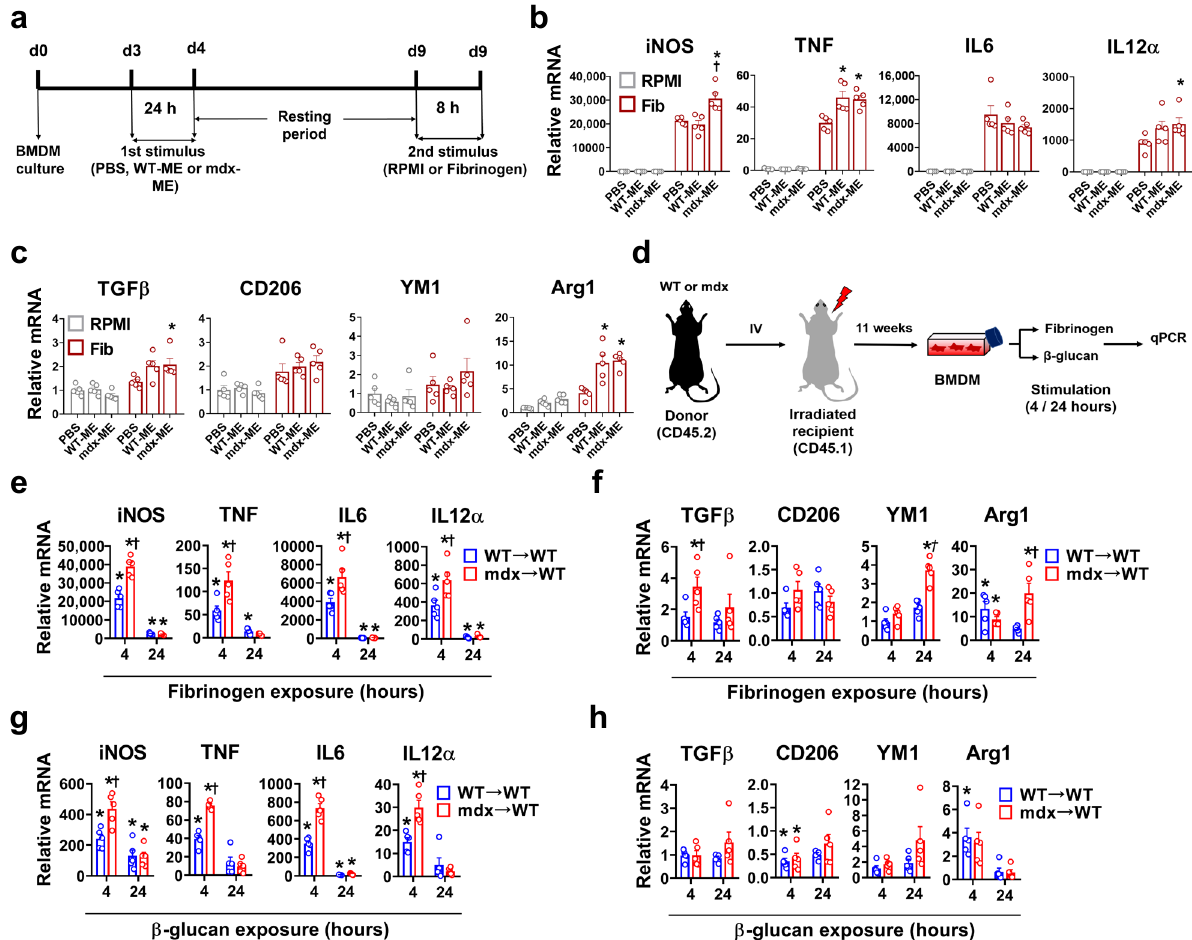
Fig. 4 BMDM exposed to muscle damage show a trained-like phenotype both in vitro and in vivo. a Experimental design for WT- or mdx- muscle extract (ME) exposure to induce trained immunity in naive WT BMDM. b , c Transcript levels are shown for BMDM trained with PBS, WT-ME, or mdx-ME and then secondarily exposed to fi brinogen (Fib) or RPMI for 8 h; the mRNA levels determined by qPCR are expressed relative to the mean control (PBS-trained and RPMI-stimulated) value ( n = 5/group). d Schematic representation of the BM transplant chimeric model. At 11 weeks post-transplantation BMDM were generated from recipient mice previously transplanted with whole BM from either WT (WT → WT) or mdx (mdx → WT) mice at necrotic phase. The BMDM were stimulated with fi brinogen or β -glucan for 4 and 24 h ( e – h ); e ( n = 4 for TNF in 24 h mdx group, rest n = 5/group), f ( n = 5/group), g ( n = 4 for TNF in 4 h mdx group, rest n = 5/group), h ( n = 4 for TGF β and CD206 WT 4 h groups, rest n = 5/group). Data represent means± SEM of biologically independent samples from different mice. b , c * P < 0.05 vs. PBS-trained and † P < 0.05 vs. WT-ME trained. e – h * P < 0.05 vs. WT-unstimulated and † P < 0.05 vs. WT-stimulated group at a given time point (one-way ANOVA followed by a Tukey post-hoc test, two-tailed). See Source Data fi le for the exact P